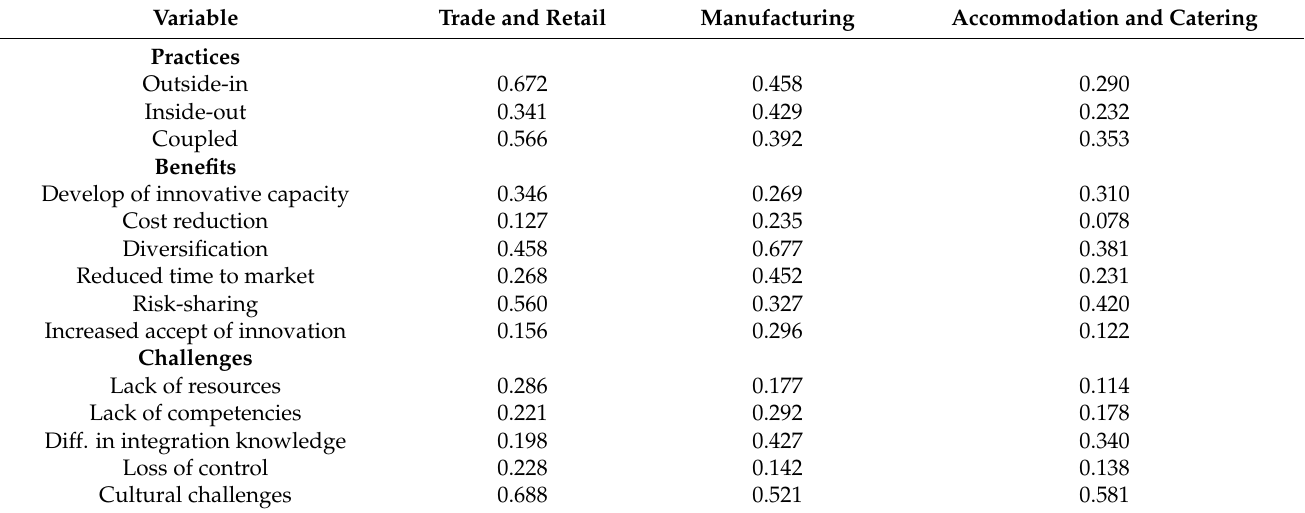
Table 6. ANOVA analysis for the business sector.